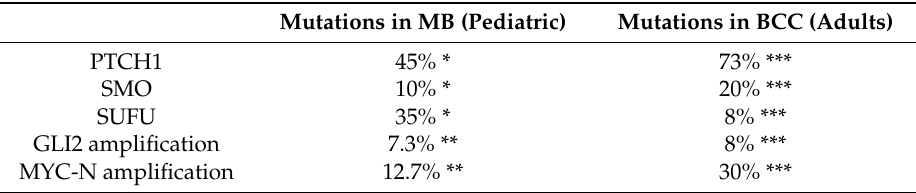
Table 1. Frequency of mutations in Hh-dependent MB and